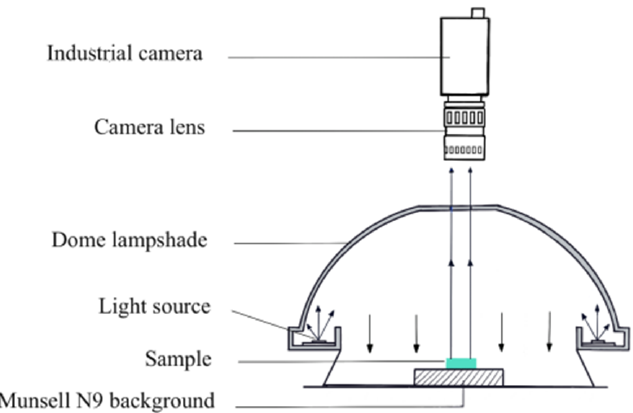
Figure 6. Schematic diagram of a computer vision system measuring device.